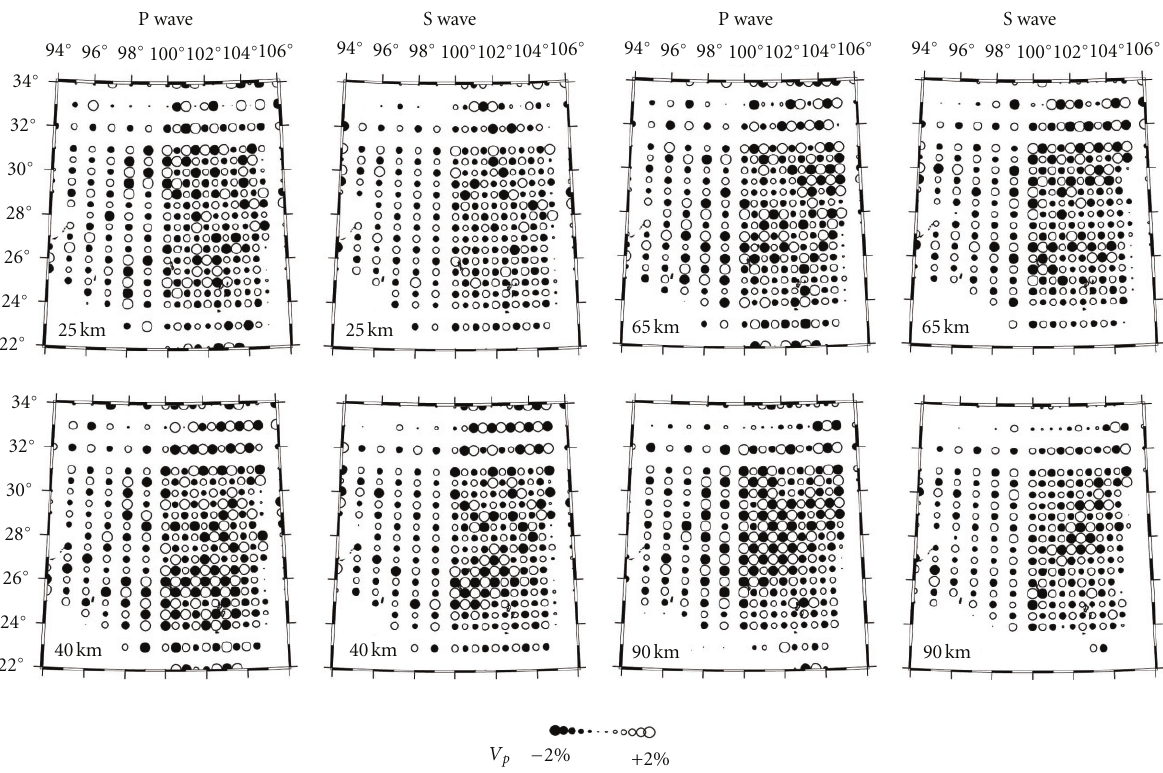
Figure 4: Plan views of the checkerboard resolution tests (CRTs) for the P- and S-wave tomography. The input amplitudes of the velocity perturbations are ± 2% at every grid nodes. The layer depth is shown at the lower-left corner of each map. The scale for the velocity perturbations (in %) relative to the 1D initial velocity model is shown at the